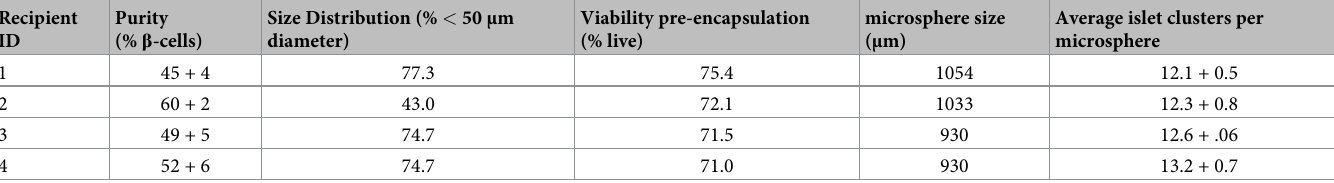
Table 1. Islet characteristics for biocompatibility/safety study. Recipient